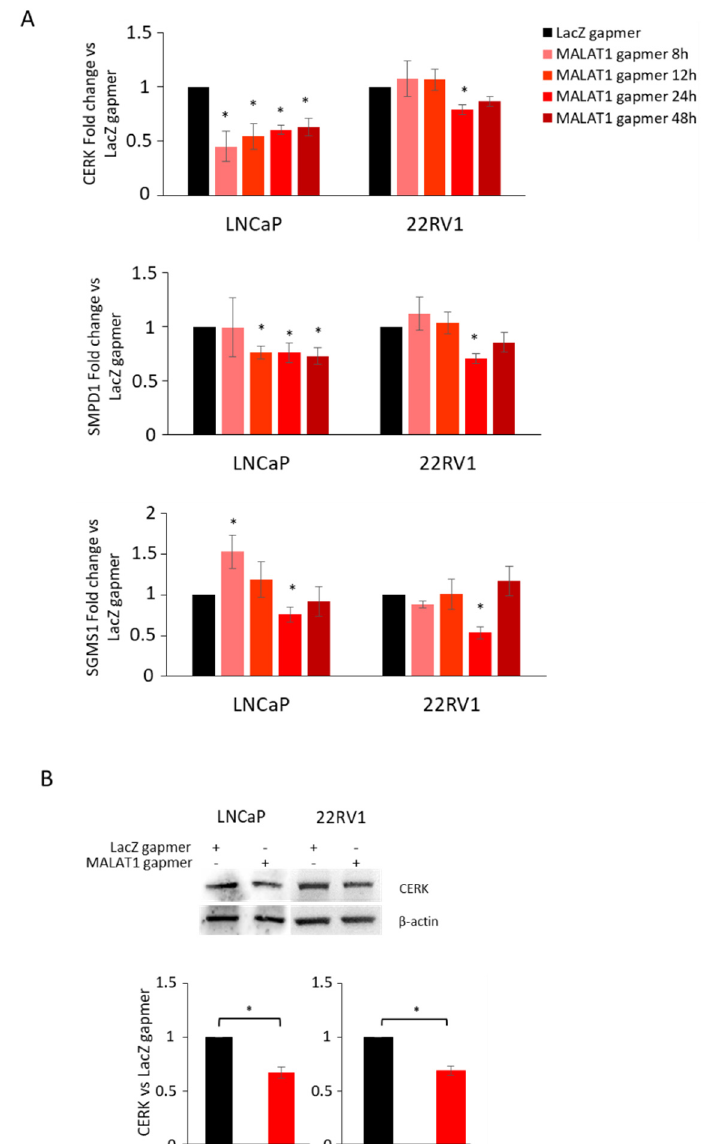
Figure 5. Effects on sphingolipids/ceramide enzymes in MALAT1-depleted PCa cells cultured with hormone-deprived (SS) serum: ( A ) CERK, SMPD1, and SGMS1 transcripts quantified by qRT-PCR in LNCaP and 22RV1 cells grown were grown in SS condition after transfection with specific (MALAT1) or control (LacZ) gapmers at different time points. ( B ) Representative CERK western blot and relative densitometry analysis in LNCaP and 22RV1 cells upon 16 h and 24 h, respectively, from transfection with specific (MALAT1) or control (LacZ) gapmers. B-actin was used as a loading control. Data are represented as the mean of fold change vs. LacZgapmer ± SEM (N = 4). * p < 0.05 MALAT1gapmer vs.